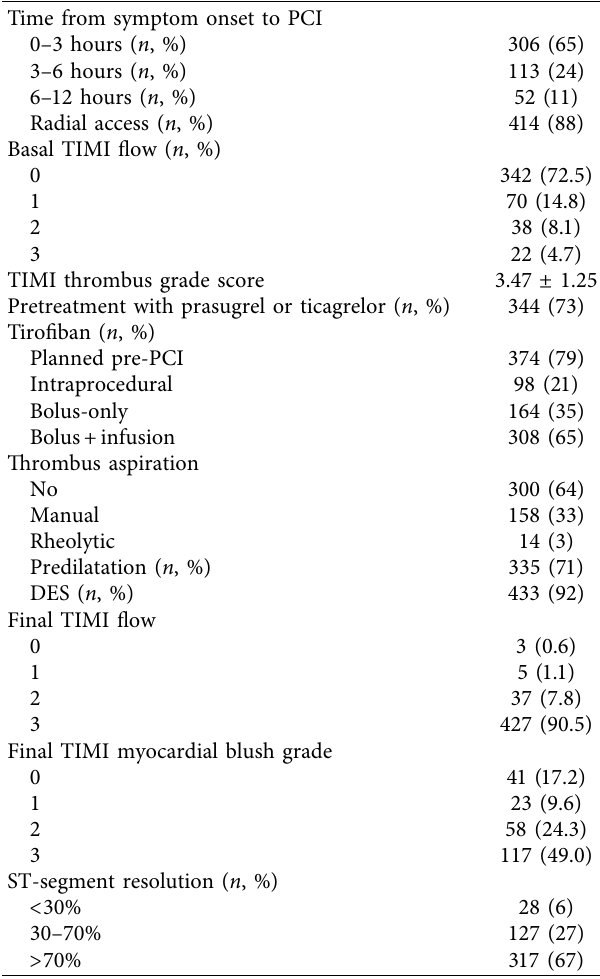
Table 2: Clinical characteristics. Table 3: Procedural